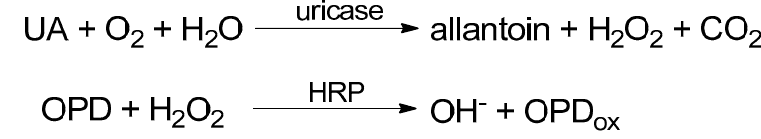
Figure 5. Fluorescent strategy to detect uric acid using lactate uricase and horseradish peroxidase (HRP).